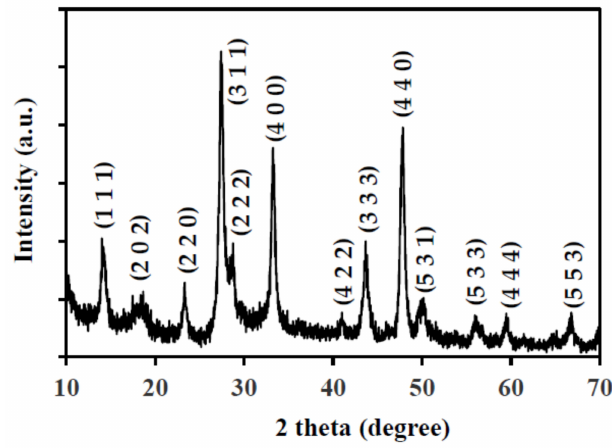
Figure 1. XRD pattern of the as-prepared SnIn 4 S 8 photocatalyst.